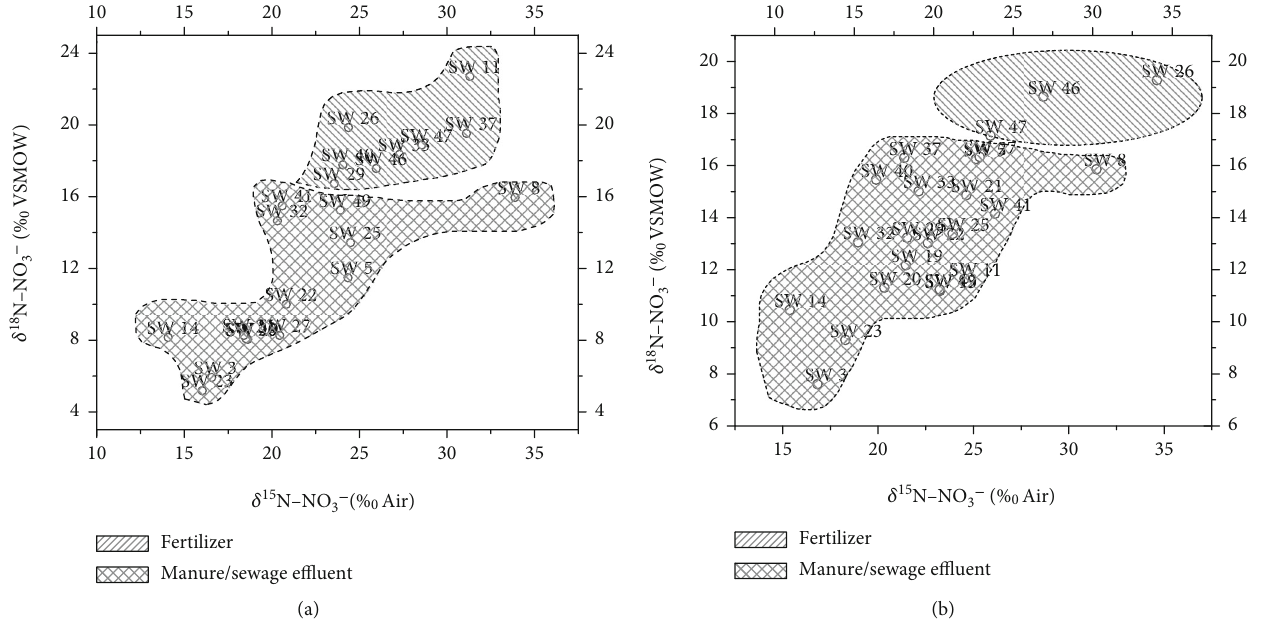
Figure 12: Dual-isotope signatures in shallow wells during the (a) wet and (b) dry